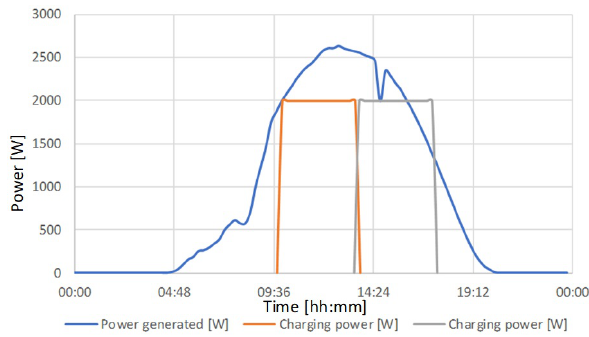
Figure 4: The power generated by the carport and consumed by the vehicle during